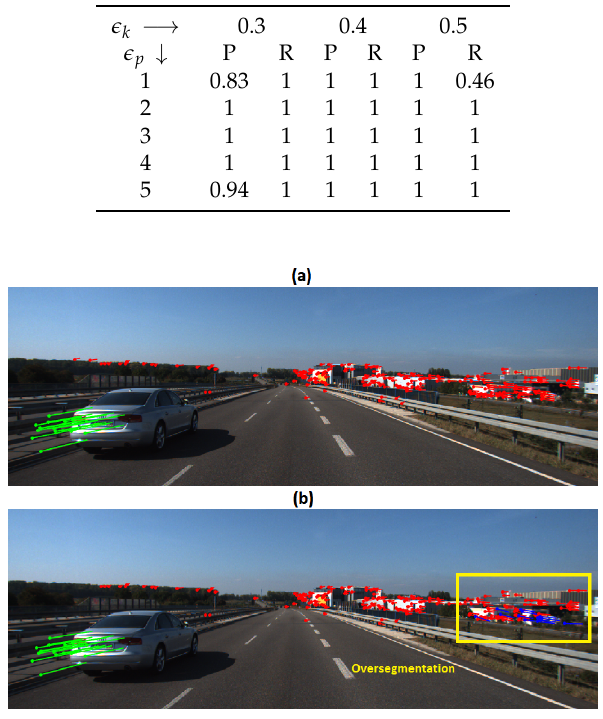
Figure 2. Results of Scene 1: ( a ) Motion trajectories; ( b ) Oversegmentation example.